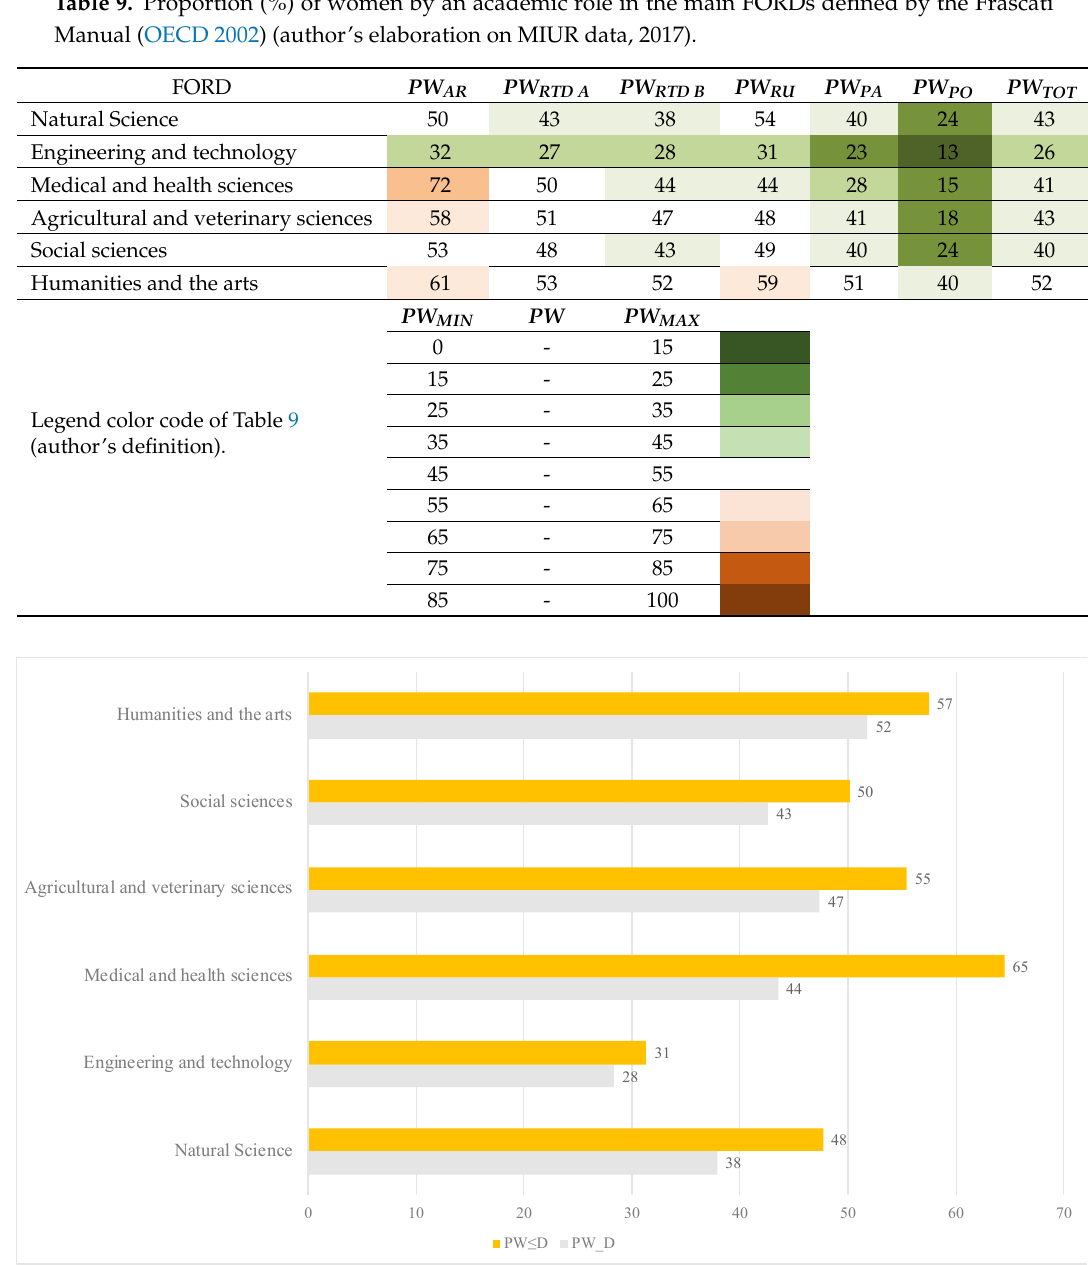
Figure 3. Proportions (%) of women in fixed-term positions and at the recruitment stage by main field of science (the author’s elaboration on MIUR data, 2017).